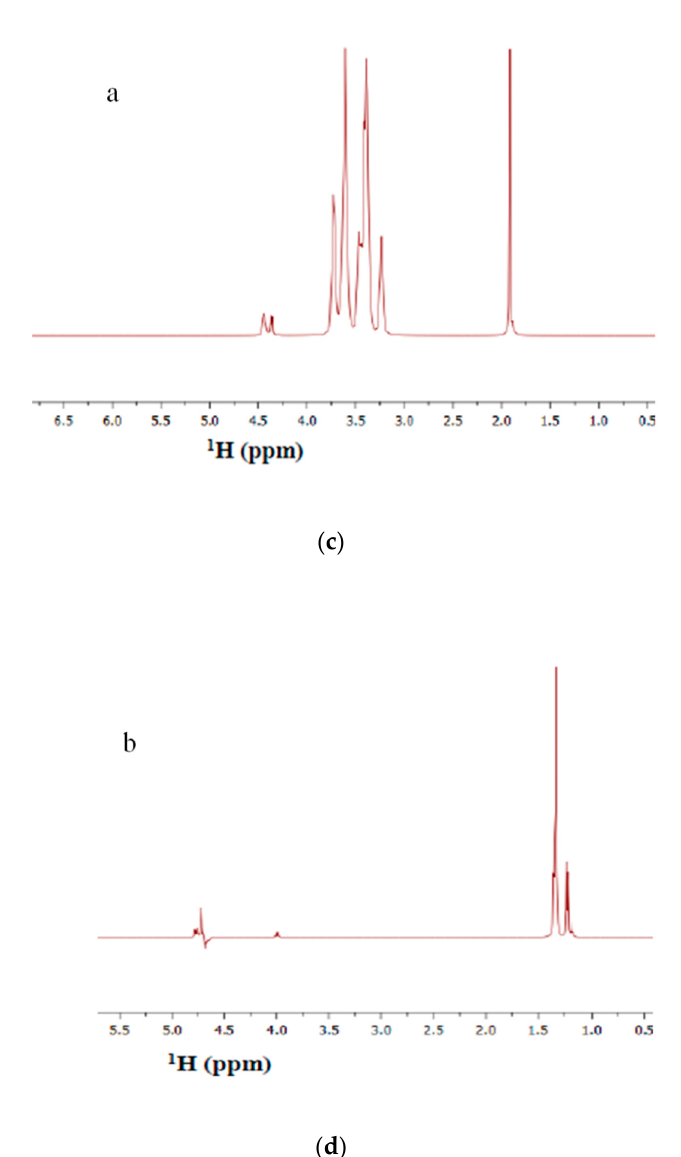
Figure 6. ( a ) NMR spectrum of the sample of T15F1 of HA-PLA DAC ® sterilized and degraded as in Table 1 as reported in Materials and Methods. ( b ) DOSY spectrum of the sample T15F1. The DOSY indicates the presence of two diffusive fronts due to chemical species “ a” and “ b”. Front “ a ” represents the residual HA polymer with a MW slightly decreased with respect to the result in Figure 3, showing D = 1.30 × 10 − 10 m 2 s − 1 corresponding to a MW of 37 kDa. Front “ b ” represents the fragments of PLA released by hydrolysis of the conjugated bridge. The region of the vertical profile circled in red shows the presence of the fragments with a higher diffusivity (3.9–2.50 × 10 − 9 m 2 s − 1 ).The region circled in blue is attributed to the diffusive front of the residual deuterium hydrogen oxide HDO at 4.76 ppm. For D 2 O residual protons, the value of D found was 3.79 × 10 − 9 m 2 s − 1 . ( c ) Slice of front “ a” of the DOSY spectrum. ( d ) Slice of front “ b” of the DOSY spectrum.